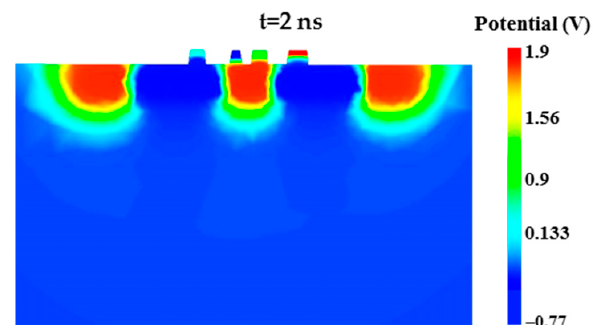
Figure 4. The potential evolution for the case of SEE in the PMOS source–source (PSS) direction.